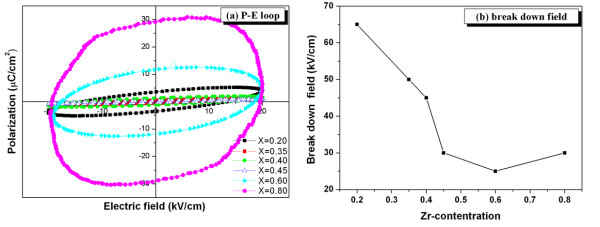
P-E hysteresis loops (a) and the breakdown field (b) of Bi0.5Na0.5Ti1-xZrxO3 ceramics. Where x = 0.20, 0.35, 0.40, 0.45, 0.60, and 0.80 mole fraction.